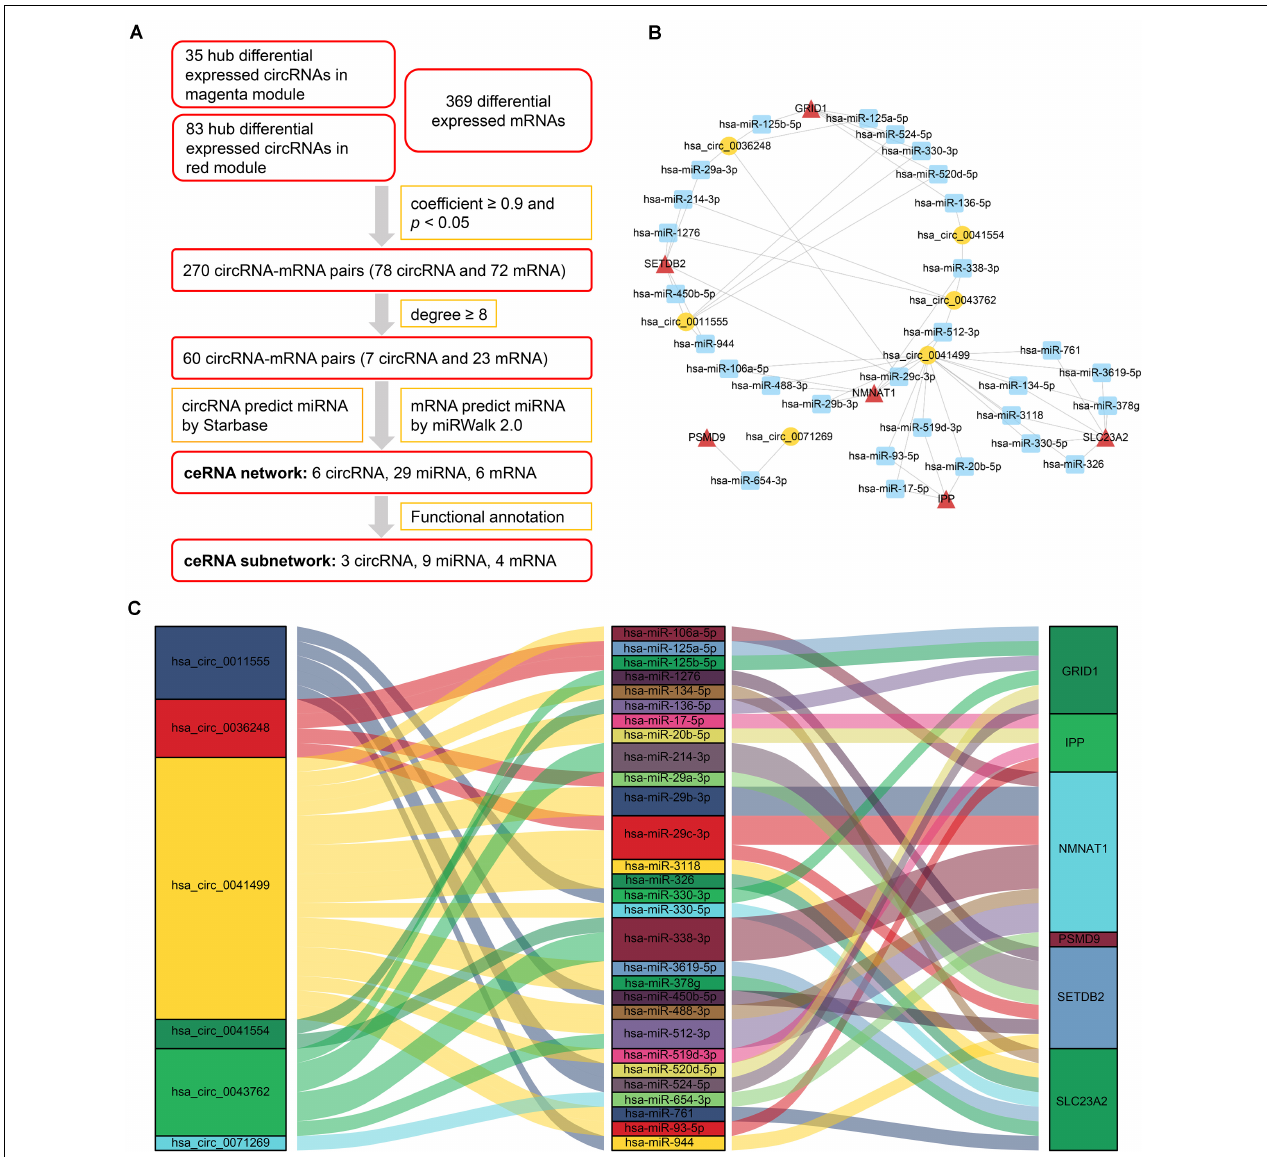
FIGURE 4 | CeRNA network of circRNA–miRNA–mRNA in HCM. (A) Flow chart for ceRNA network construction. Correlation coefficients were used for screening of circRNA–mRNA pairs. Starbase and miRWalk were used to predict the potential interacting miRNAs. (B) CircRNA–miRNA–mRNA network. Circular block represented circRNAs, square block represented miRNA, and triangle block represented mRNA. A ceRNA network including 6 circRNAs, 29 miRNAs, and 6 mRNAs was constructed by integrated analysis. (C) Sankey diagram of circRNA-associated ceRNA network. Each color block corresponded to one RNA, and the link between two blocks indicated a potential interaction between two RNAs. The Sankey diagram clearly showed the potential interactions between 6 circRNAs and 29 miRNAs as well as interactions between 29 miRNAs and 6 mRNAs. HCM, hypertrophic cardiomyopathy; circRNA, circular RNA; miRNA, microRNA; mRNA, messenger RNA; ceRNA, competing endogenous